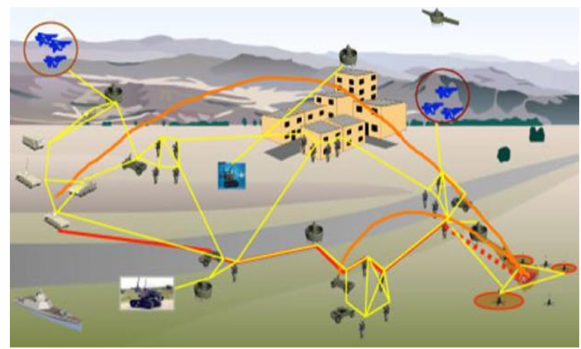
Figure 1. An example of the battlefield